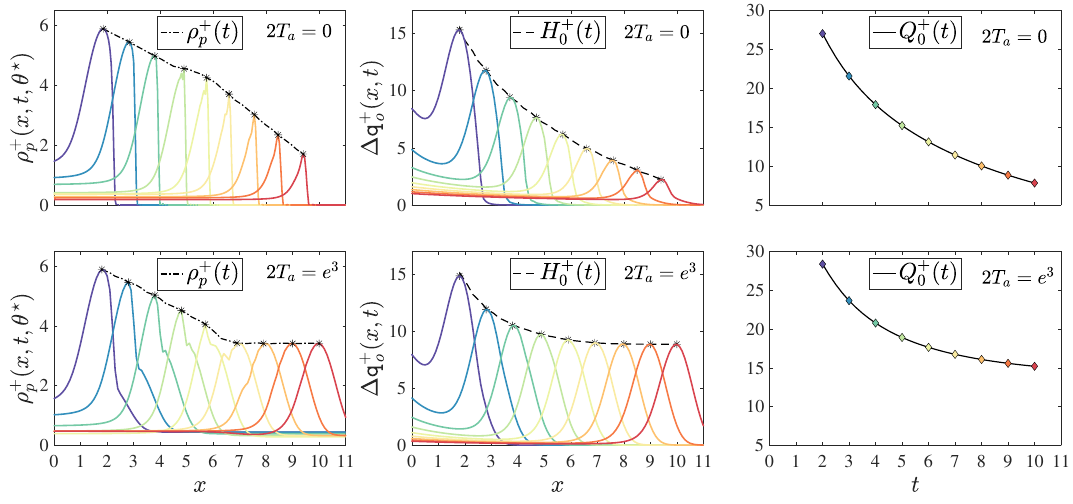
( x, t, θ ? ) and its maximum (stars) ρ + p ( t ) . Right: the function Q + 0